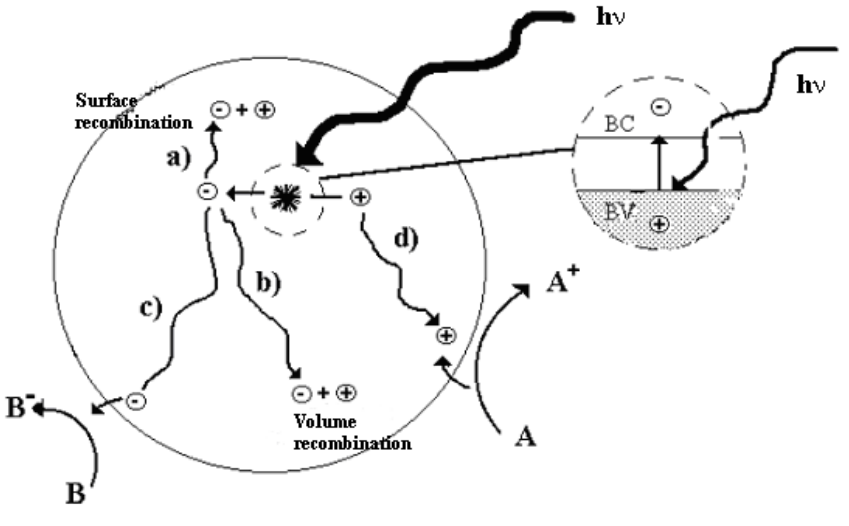
Figure 1. Photocatalytic process over TiO Ciencia y Tecnologia para el Desarrollo ( Red CYTED